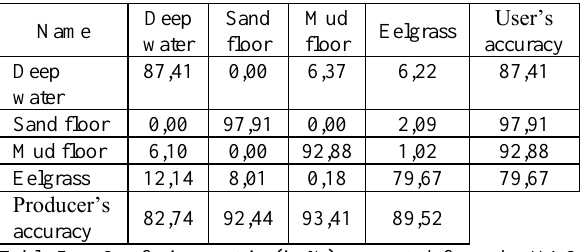
Confusion matrix (in %) computed from the MLC classified image produced from the PCI Geomatica RGB mosaic of Shediac Bay.